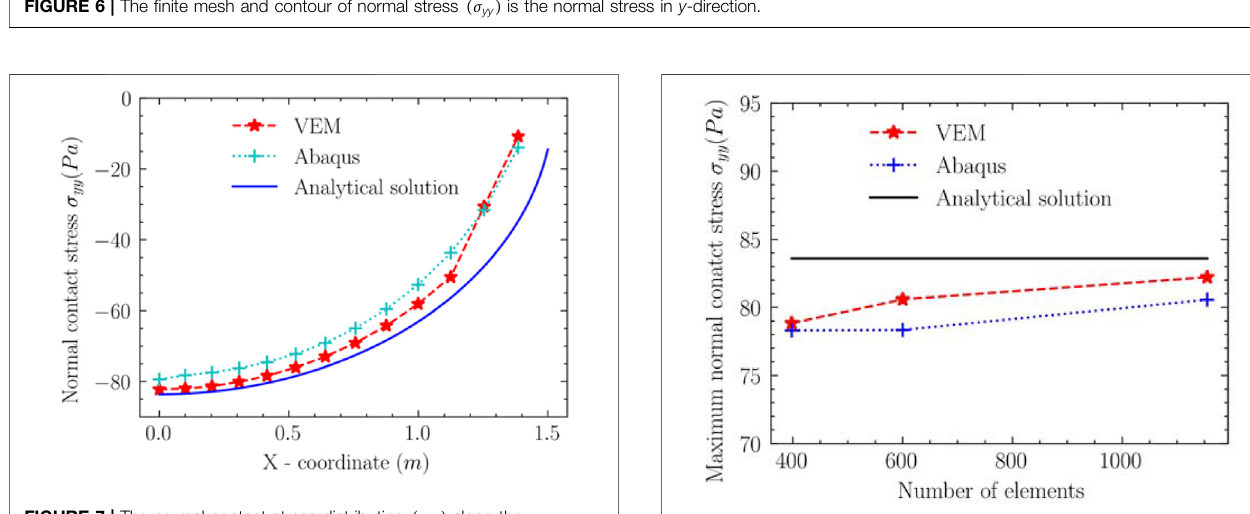
FIGURE 6 | The fi nite mesh and contour of normal stress ( σ yy ) is the normal stress in y -direction.